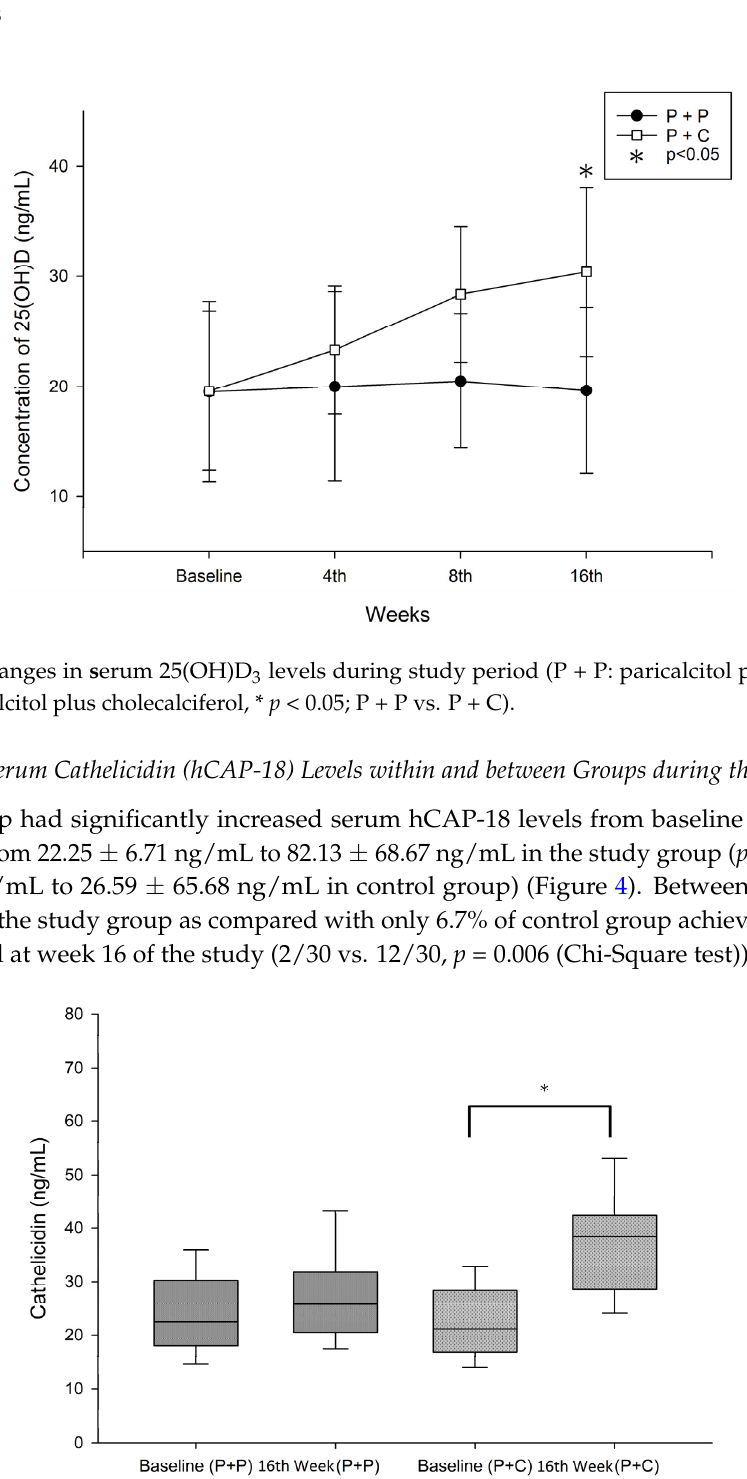
Figure 4. Changes in serum cathelicidin (hCAP ‐ 18) levels during study period (P + P: paricalcitol plus placebo, P + C: paricalcitol plus cholecalciferol; * t ‐ test, Baseline vs. 16th week in P + C group, p < 0.05).